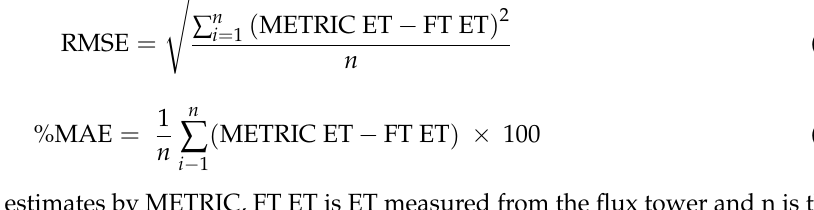
Table 3. Path/row, date and satellite platform for the images used in the METRIC processing for the daily ET estimation.